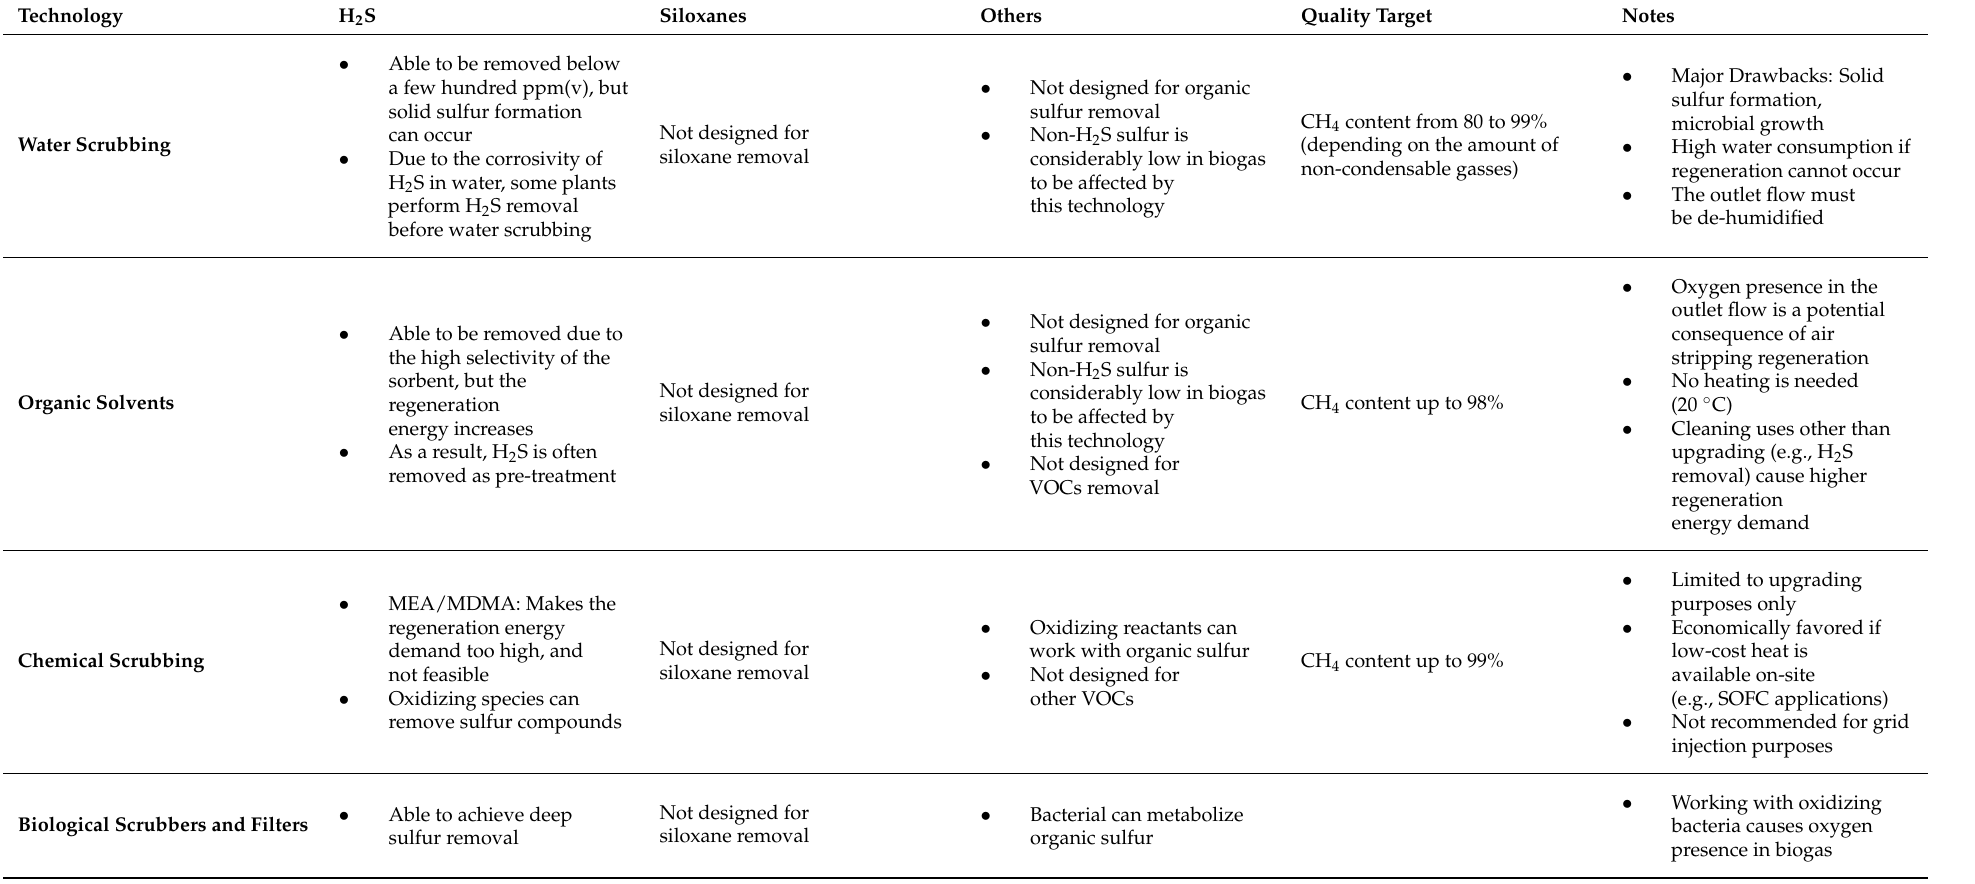
Table 10. Final comparison of the biogas cleaning and upgrading technology analyzed in the previous